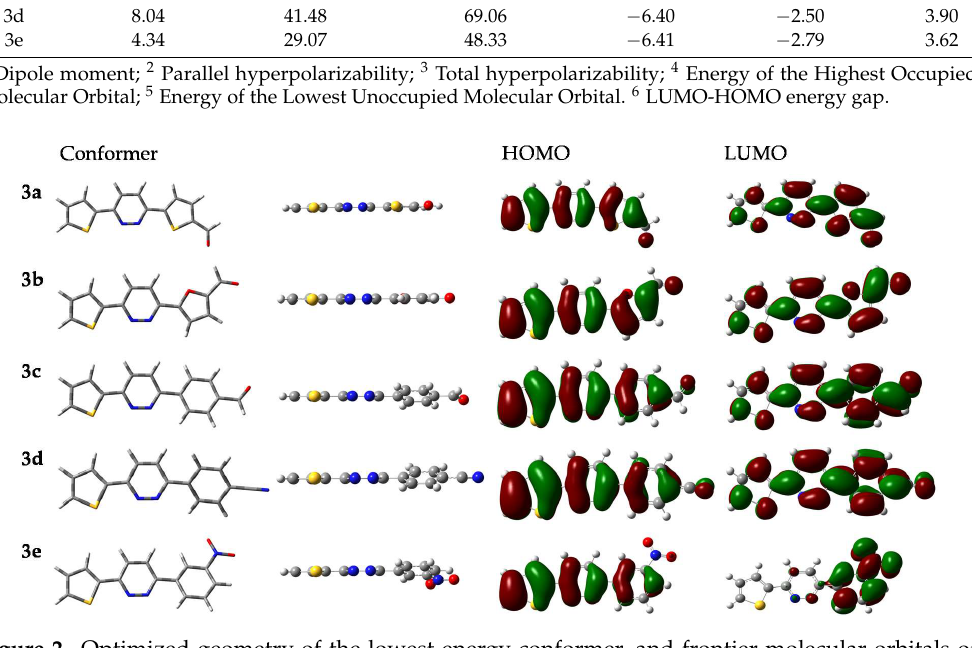
Figure 2. Optimized geometry of the lowest energy conformer, and frontier molecular orbitals of thienylpyridazines 3a – e (HOMO: Highest Occupied Molecular Orbital; LUMO: Lowest Unoccupied Molecular Orbital).